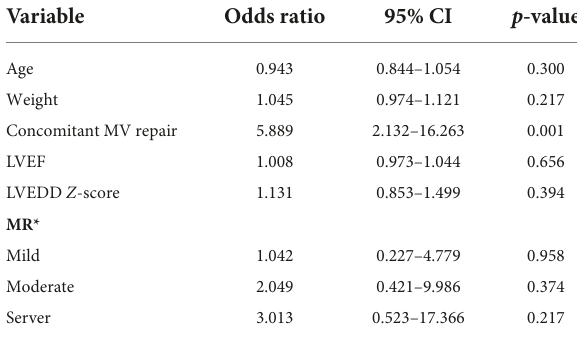
TABLE 4 Multivariate analysis for the degree of mitral regurgitation improved after the